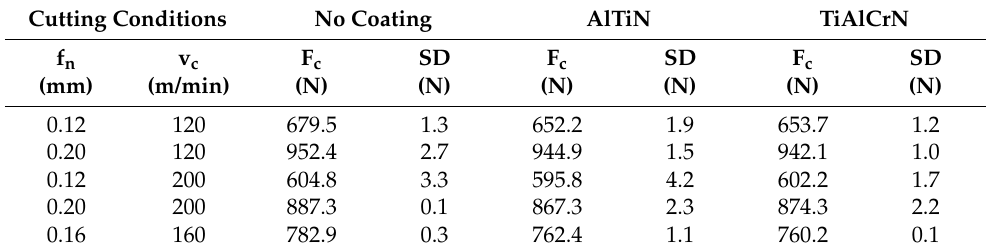
Table 8. Mean cutting force values with standard deviations.